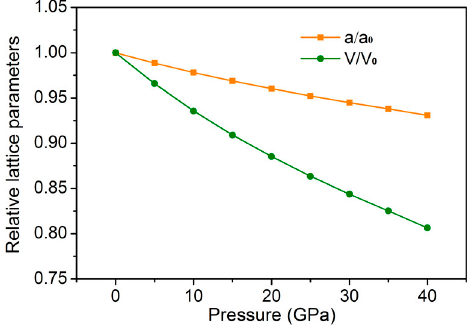
Figure 3. The variation of relative lattice constant a/a 0 and relative volume V/V 0 with pressure. Table 2. Structural parameters of GaFe(CN) 6 under different pressures.